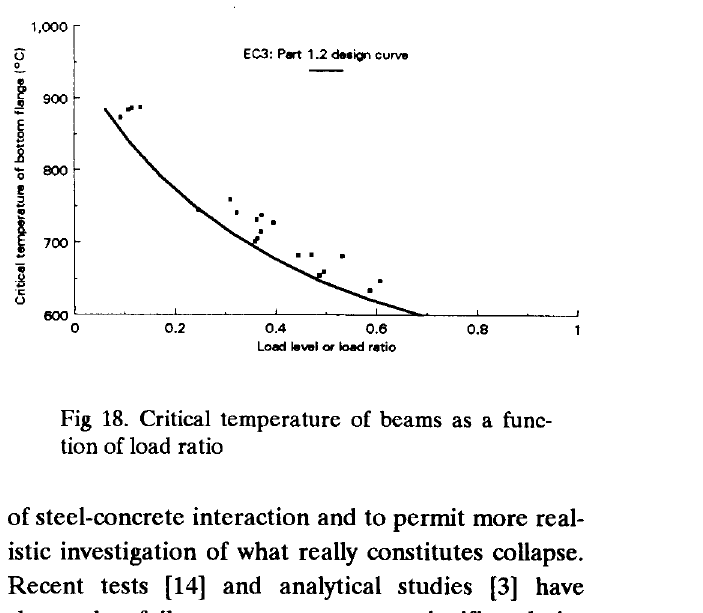
EC3: Part 1.2 design curve